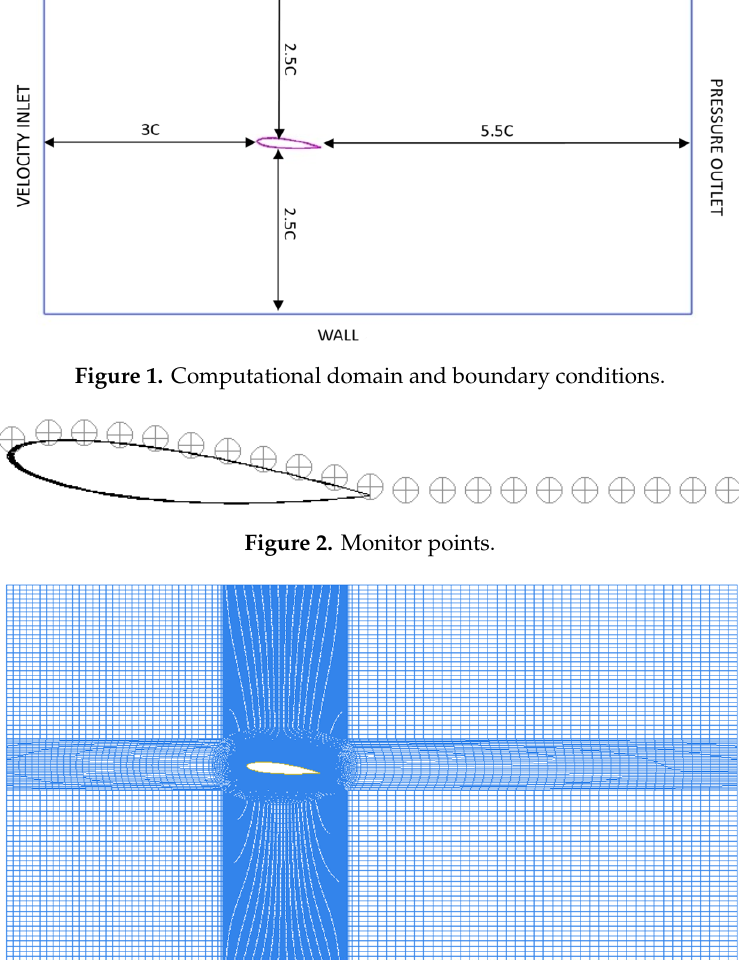
Figure 1. Computational domain and boundary conditions.